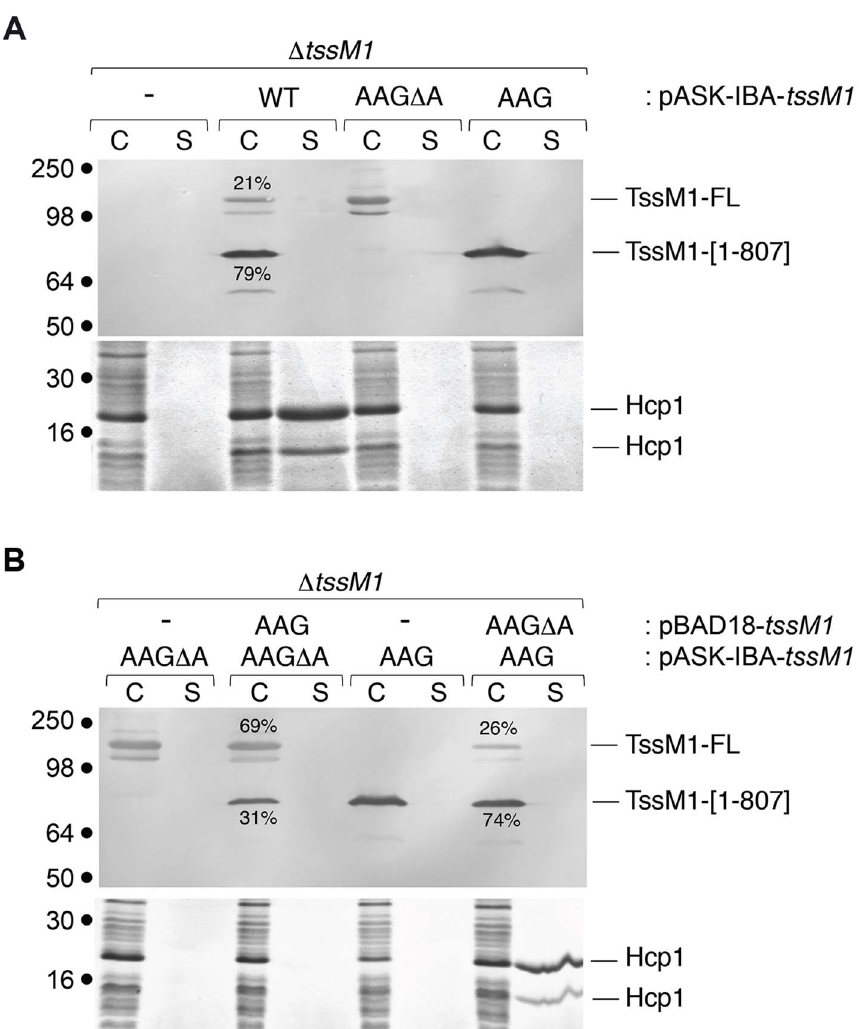
Figure 5. The ratio between the two TssM1 variants is critical for CTS1 T6SS function. Hcp release assays. C. rodentium D tssM1 cells expressing WT tssM1 (WT; producing both forms of TssM1: TssM1-FL and TssM1[1–807]) or TssM1 variants bearing mutations in the poly-A tract (AAG; producing only the TssM1[1–807] variant) or mutations in the poly-A tract and a deletion of the last nucleotide (AAG D A; producing only the TssM1-FL variant) from the pASK-IBA37 + vector (A) or producing the indicated variants from the pBAD18 and pASK-IBA37 + vectors (B). Extracellular proteins were isolated by separating whole cells (C) and the supernatant fraction (S) from cultures induced with arabinose and anhydrotetracyclin. TssM1 variants were immunodetected using the anti-FLAG monoclonal antibody (upper panels). The relative intensities of the short and long TssM1 variants are indicated (as %). Total proteins were visualized by Coomassie blue staining (lower panels). Molecular mass markers are indicated on the left.